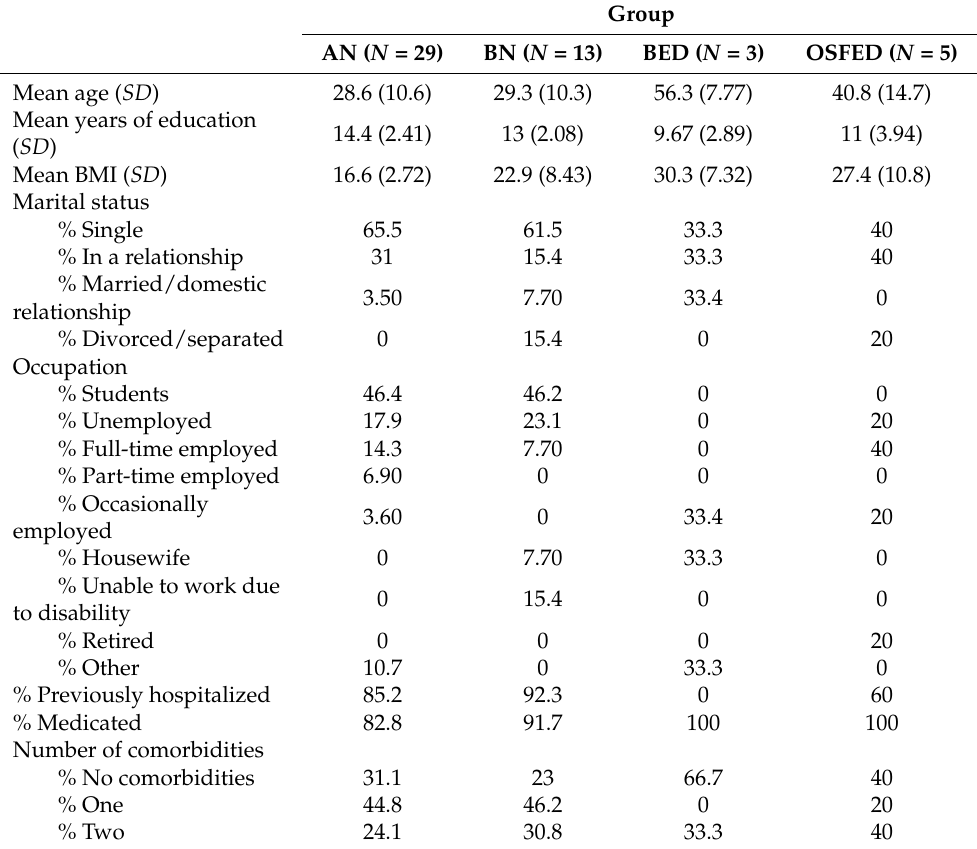
Table 1. Sociodemographic and clinical characteristics of the four subgroups of patients. Group AN ( N = 29) BN ( N = 13) BED ( N = 3) OSFED ( N =